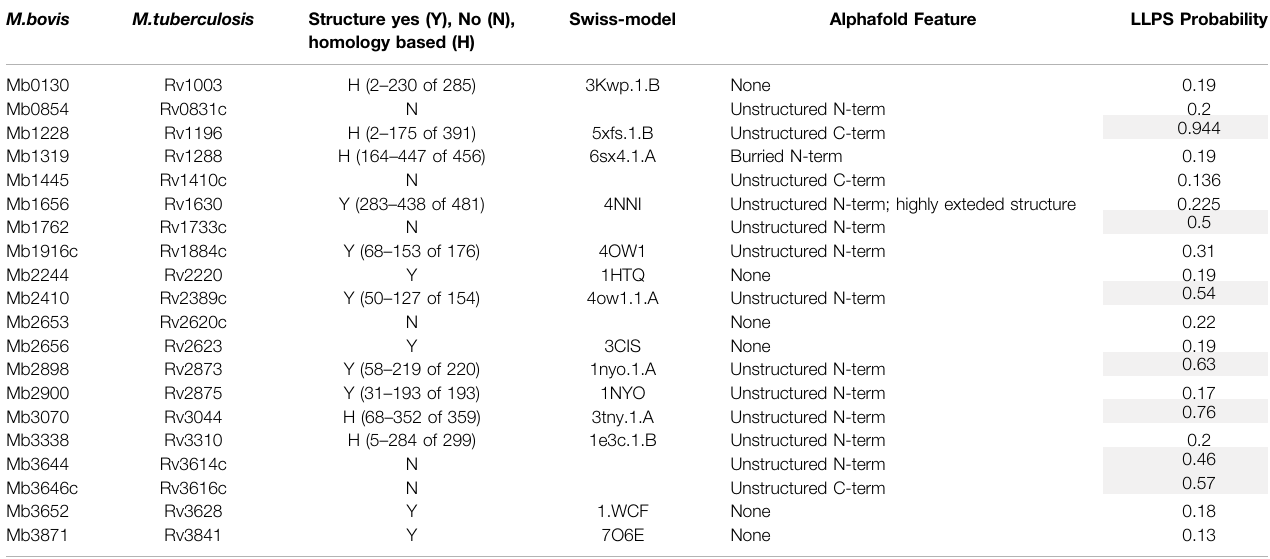
TABLE 2 | Known and predicted structural features of dif fi cult to express